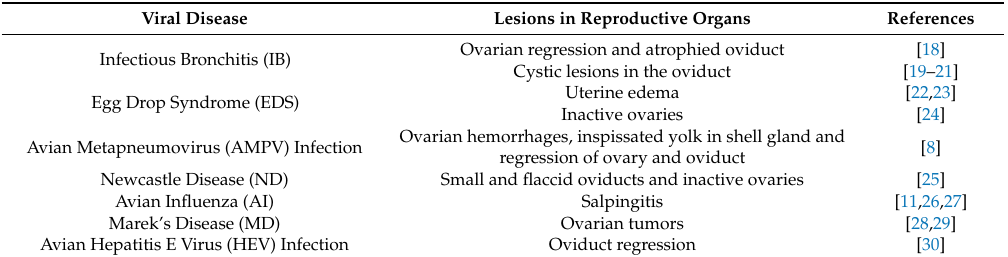
Table 2. Lesions in reproductive organs observed in di ff erent avian viral diseases. Viral